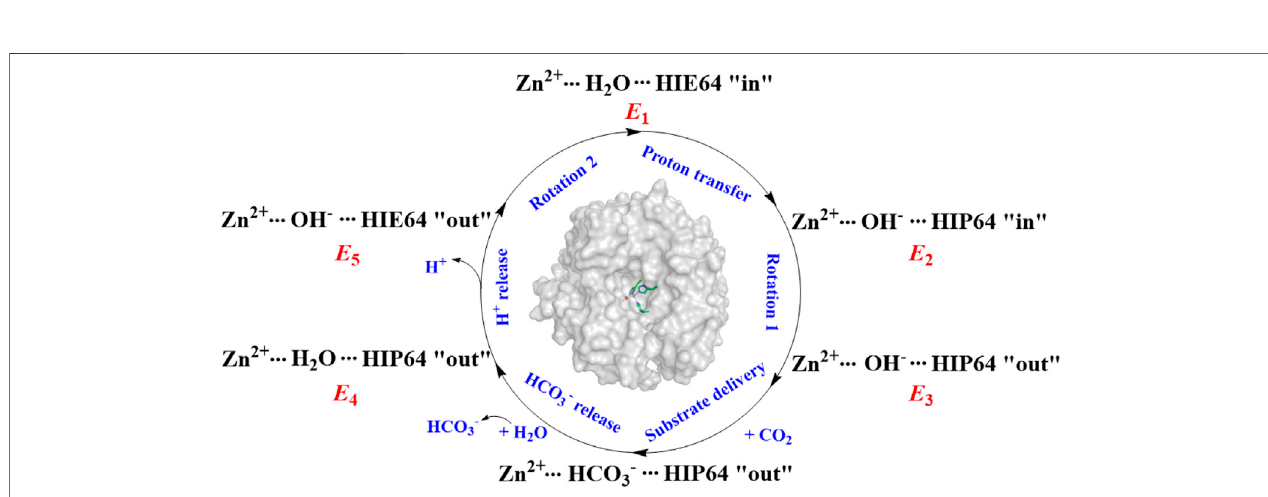
FIGURE 2 | The enzymatic hydration cycle of CO 2 by CA, where “ in ” and “ out ” stand for inward and outward conformations, respectively.